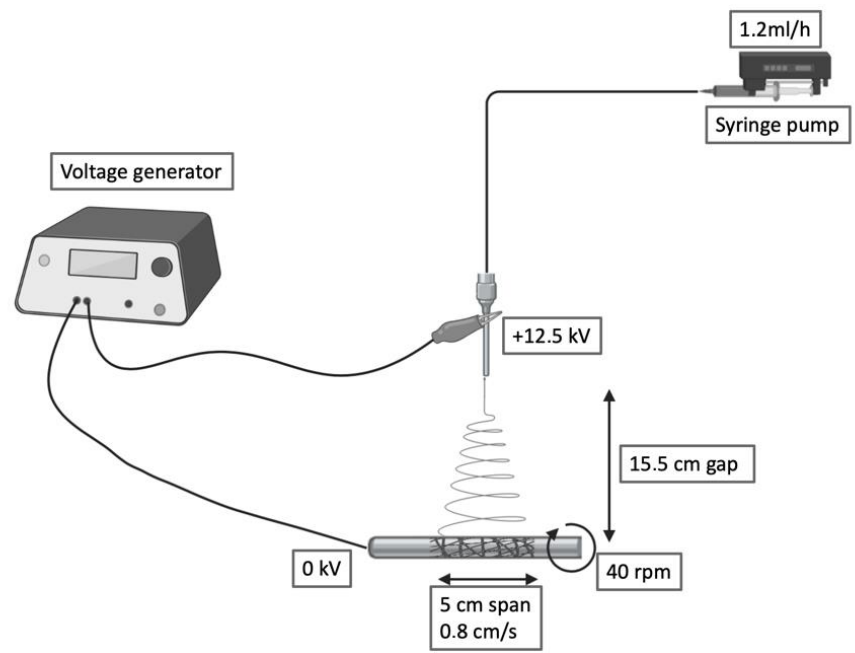
Figure 1. Schematic of the electrospinning setup and processing variables.